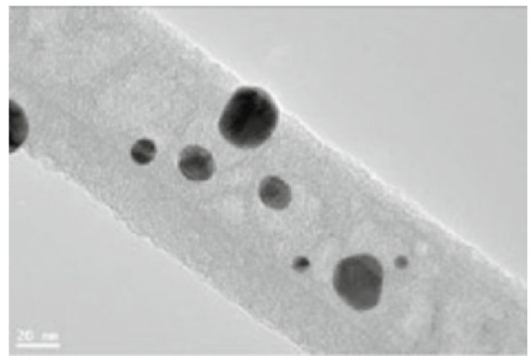
Figure 4. TEM images of Cu NPs inside a PAN NF. Reprinted with permission from Ref. [20]. Copyright © The Author(s)